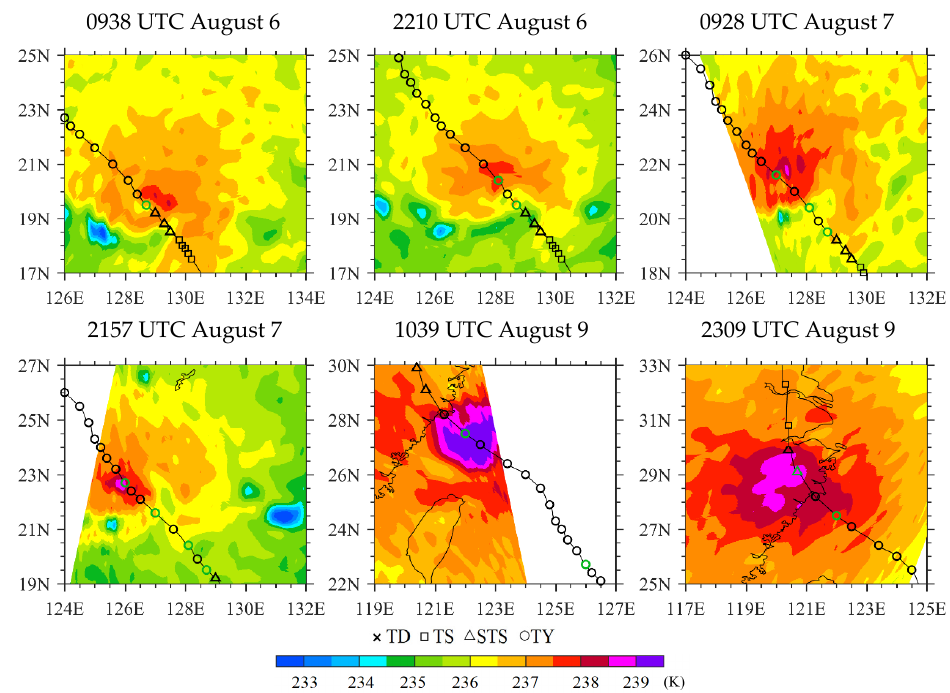
Figure 14. TB observations at channel 4 after noise mitigation at six different F17 SSMIS observing times, which are indicated on top of each panel. Also shown is the in black symbols. The best track position at the time closest to the SSMIS observations is indicated in green symbol.